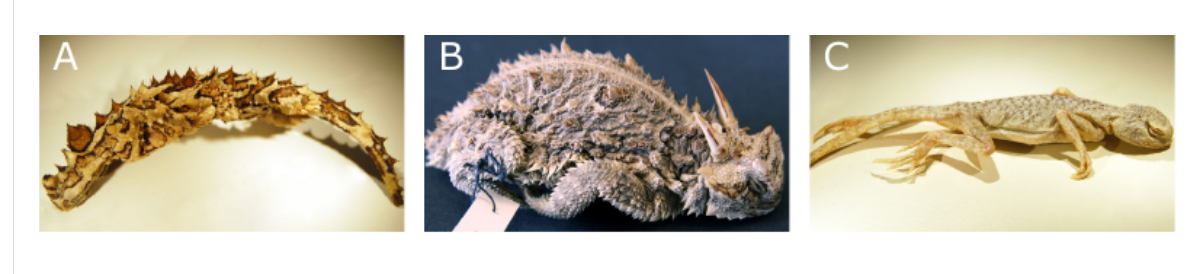
Figure 1: The three lizard species under investigation. (A) Moloch horridus with an array of spikes covering the entire upper side of the body. The snout–vent length is about 90 mm and the total length is about 140 mm. (B) Phrynosoma cornutum also exhibits thorny appendages. The snout–vent length is about 95 mm. (C) Phrynocephalus arabicus has a velvet like surface and no apparent protuberations. The snout–vent length is about 80 mm.